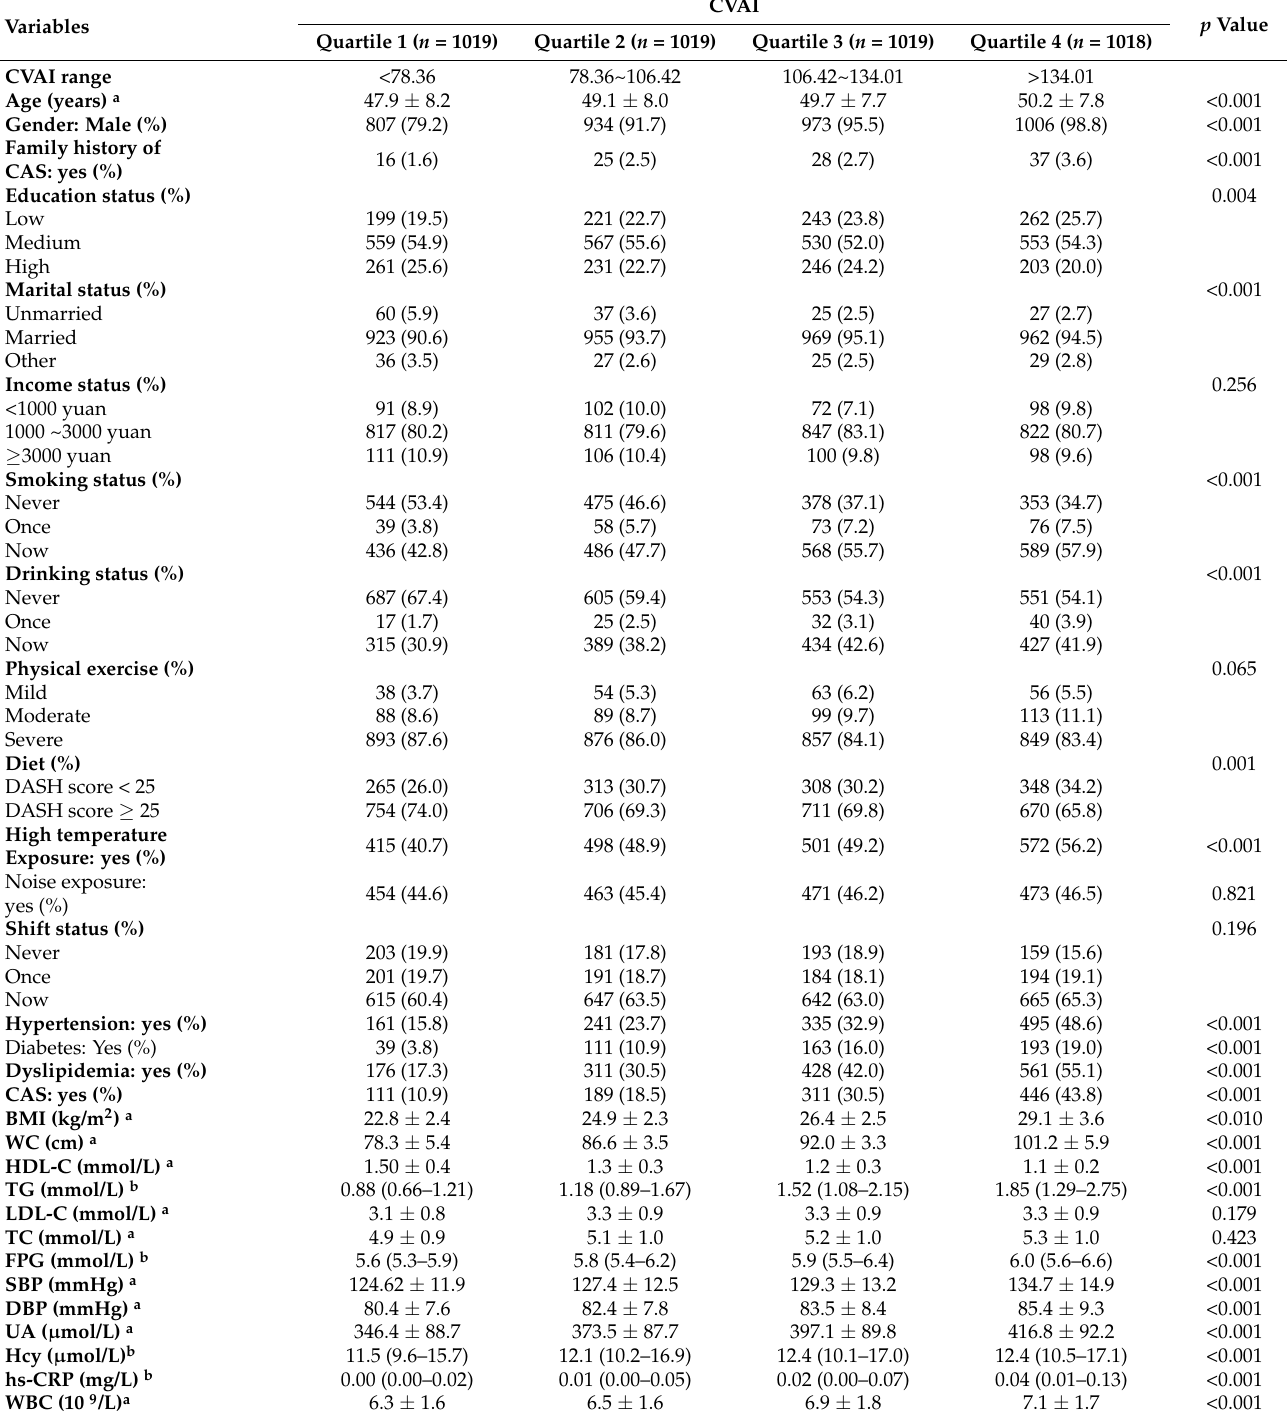
Table 1. General characteristics of the study